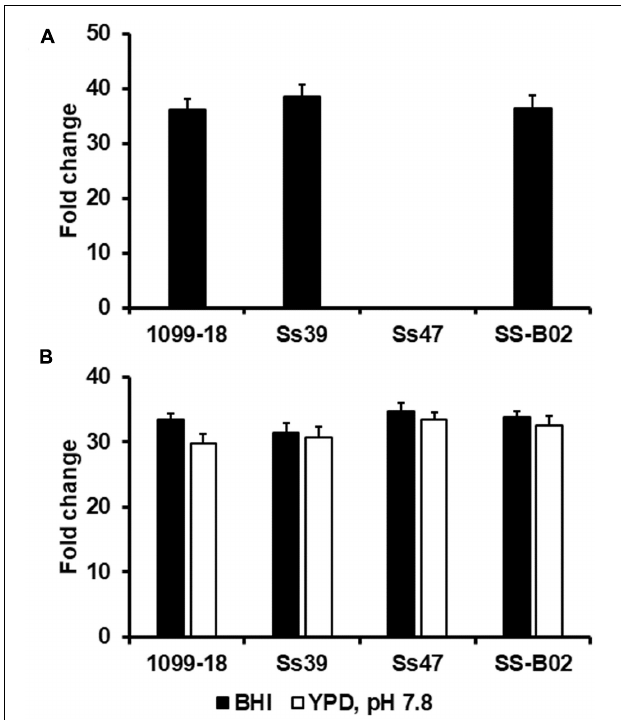
FIGURE 6 | Expression of the gene encoding for β -fructofuranosidase activity and the hybrid histidine kinase DRK1 in different strains of S. schenckii sensu stricto . In (A) , cells were grown YNB added with 3% sucrose and were incubated at 28 ◦ C per 72 h. Total RNA was extracted, cDNA synthesized with oligo(dT) primer (20 mer) and the gene expression was quantified by RT-qPCR using specific primers (see Table 1 ). The reference condition to calculate the fold change was cells grown in YNB added with 3% glucose and the encoding gene for the ribosomal protein L6 was used as endogenous control. In (B) , cells were grown at 37 ◦ C in either BHI or YPD, pH 7.8, to induce yeast-like cell formation. Total RNA was extracted, cDNA synthesized with oligo(dT) primer (20 mer) and the gene expression was quantified by RT-qPCR using specific primers (see Table 1 ). The reference condition to calculate the fold change was cells grown at 28 ◦ C in BHI or YPD, pH 4.5, respectively. In both cases, the encoding gene for the ribosomal protein L6 was used as endogenous control. One-way ANOVA was used to establish statistical significance. In both panels, P -value was for all the strains >